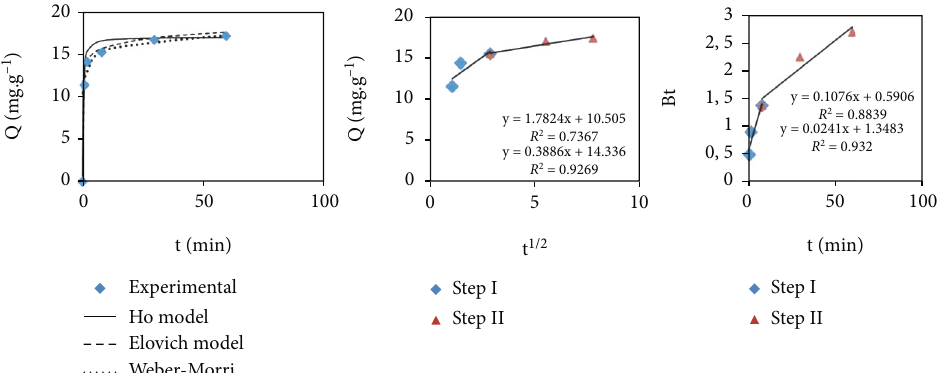
Figure 8: Experimental curves and the Ho, Elovich and Webber-Morri models of the kinetic study of Ni(II) ion adsorption in ferric clay.